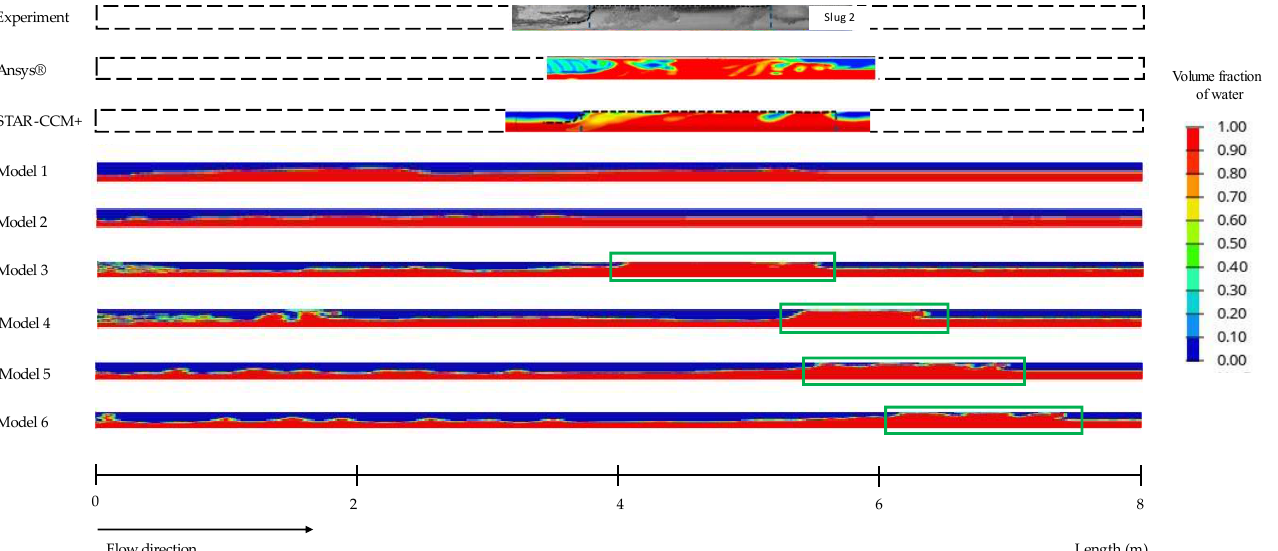
Figure 8. Flow morphology of model 1 which was extended up to simulation time of 9.8 s. 3.2. Average Slug Translational Velocity Figure 6 clearly shows that slugs were varying in lengths due to the unsteadiness nature of slug flow. This indirectly indicates that the translational slug velocity could vary along the pipe and thus an average value was presented to provide a better representation of the velocity. Table 5 summarizes the slug translational velocity for each model. It can be seen that there is no direct correlation between the time taken for the first appearance of slug to the corresponding slug translational velocity. As explained earlier, the imple- mentation of perturbation and thus slug initiation is merely an artificial introduction to generate slug as fast as possible in CFD environment. After considering the deviation fac- tor, among all models, model 3 exhibits the closest average slug translational velocity to the published experimental data [17] with a percentage difference of 1.15%. In addition, other models obtained a range of 20% to 42% of percentage difference. Based on the data of average slug translational velocity, it is shown that, in comparison to DES, the Spalart Allmaras produced the lowest percentage difference when compared to the published ex- perimental data [17]. Table 5. Slug translational velocity obtained by each model within 4 s computational time. Model